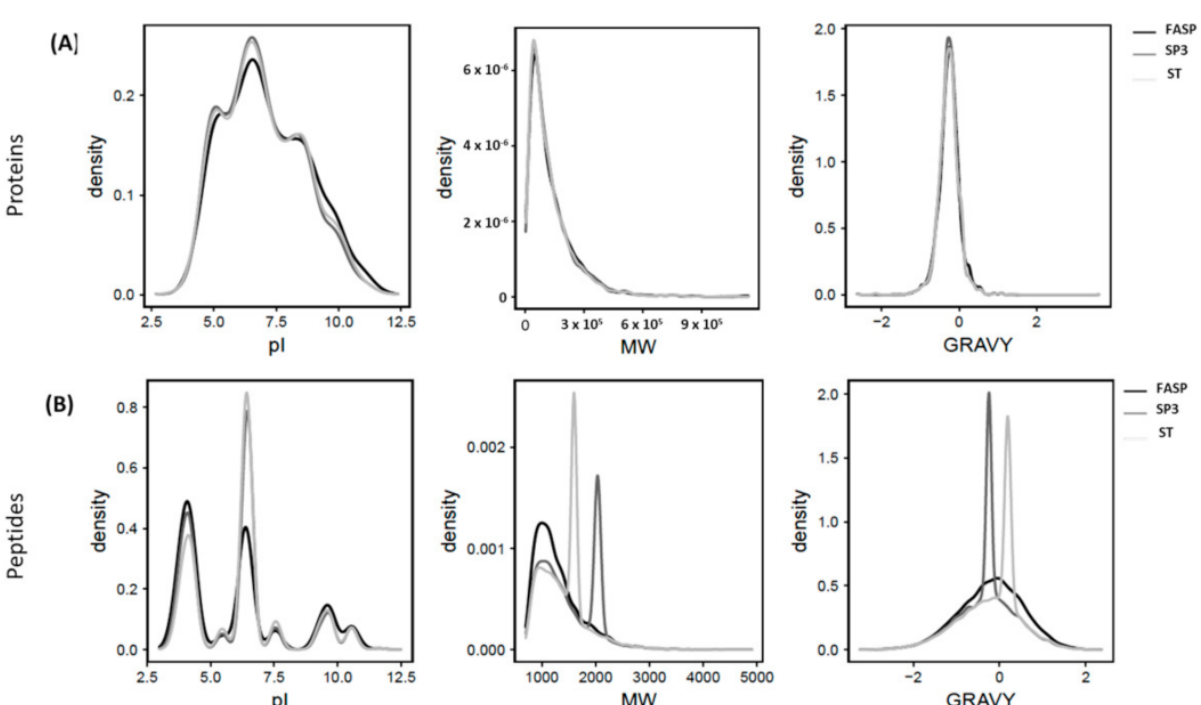
Figure 3. Distribution of isoelectric point (pI), molecular weight (Mw), and grand average of hydropathy (GRAVY) score for the proteins ( A ) and peptides ( B ) identified in filter-aided sample preparation (FASP), single-pot solid-phase-enhanced sample preparation (SP3), and stop-and-go-extraction tips (STAGETips, ST) based protein sample preparation workflows in Symbiodinium tridacnidorum combined from three biological replicates ( n =